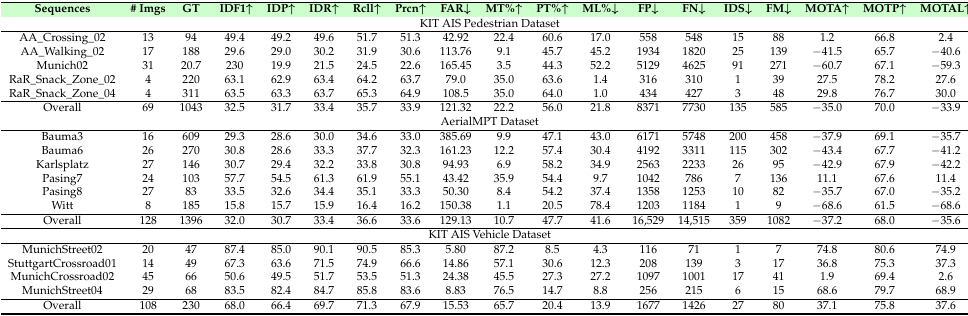
Table 10. SMSOT-CNN on the KIT AIS and AerialMPT datasets.